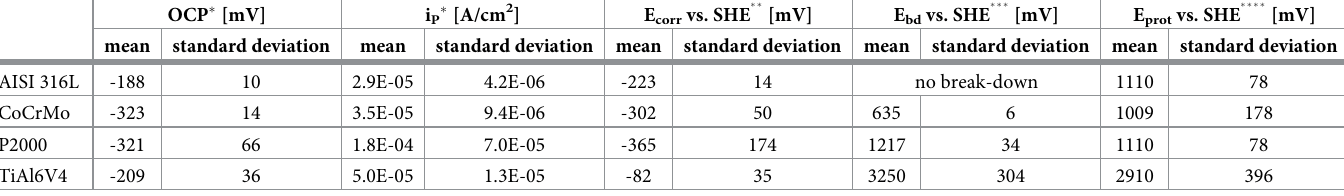
Table 2. Summary of corrosion tests (Fig